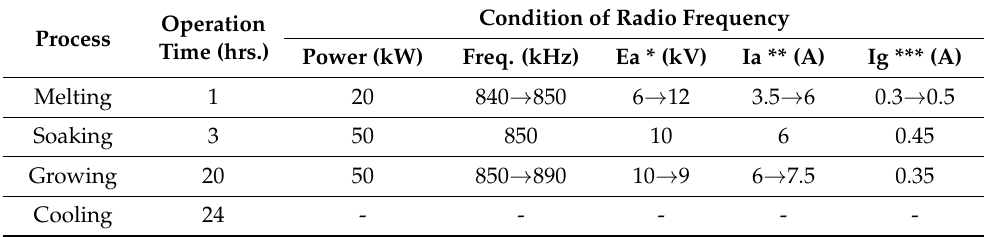
Figure 1. ( a ) Picture of the skull melting furnace used to crystallize cubic zirconia; ( b ) Pictures of the samples processed and polished with the cubic zirconia fabricated by the skull melting method; ( c ) XRD pattern of the fabricated CZ sample compared to the index data (PDF # 01-089-9069 of ZrO 2 ). Table 2. The sequence of electrical parameters in the melting, soaking and crystallization process to fabricate the cubic zirconia in the skull melting